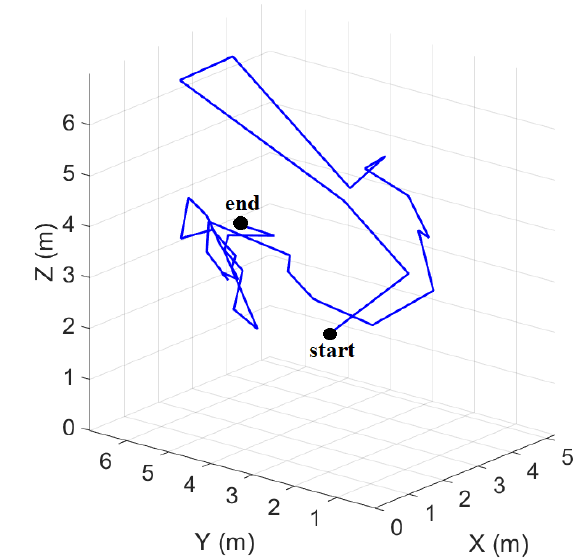
Figure 26. Position of the stereovision device during the test. The x -axis is directed east, the y -axis is directed north, and the z -axis is directed upward.